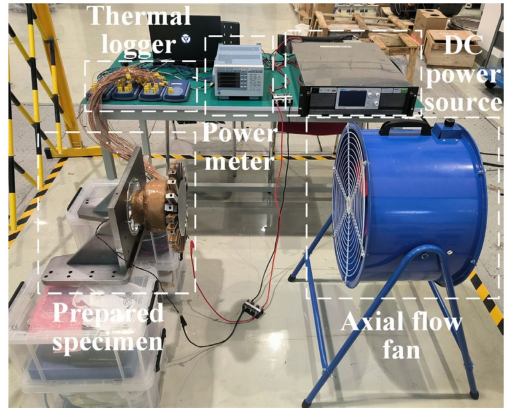
Figure 5. Experimental